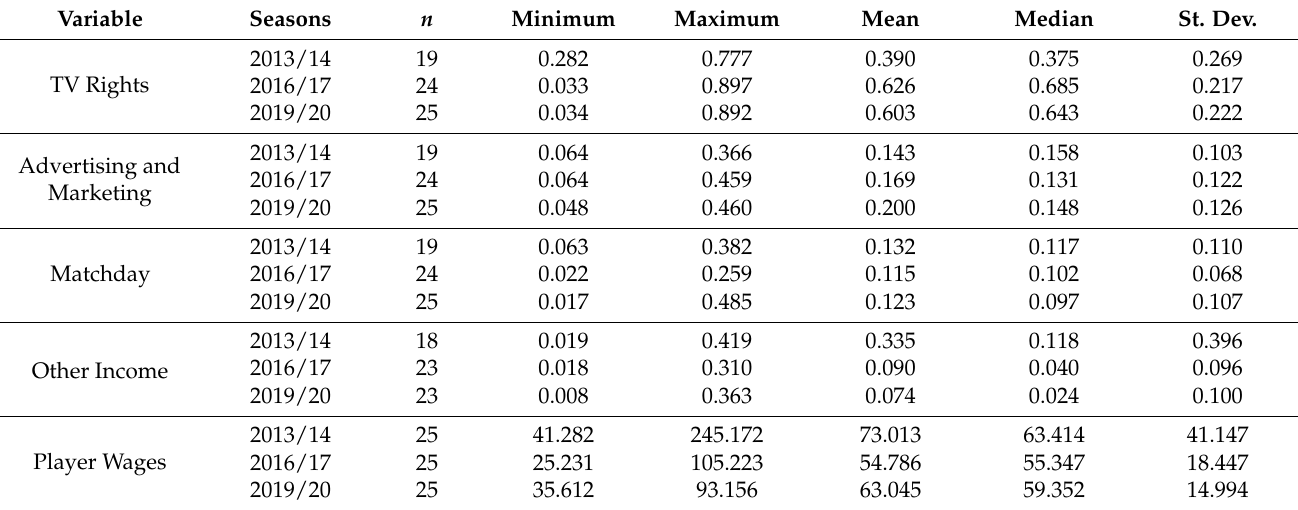
Table 3. Descriptive statistics: incomes and player